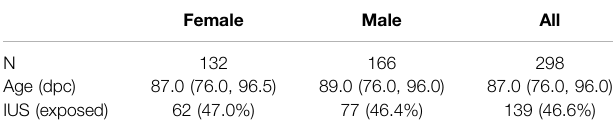
TABLE 1 | Characteristics of human fetal lung samples